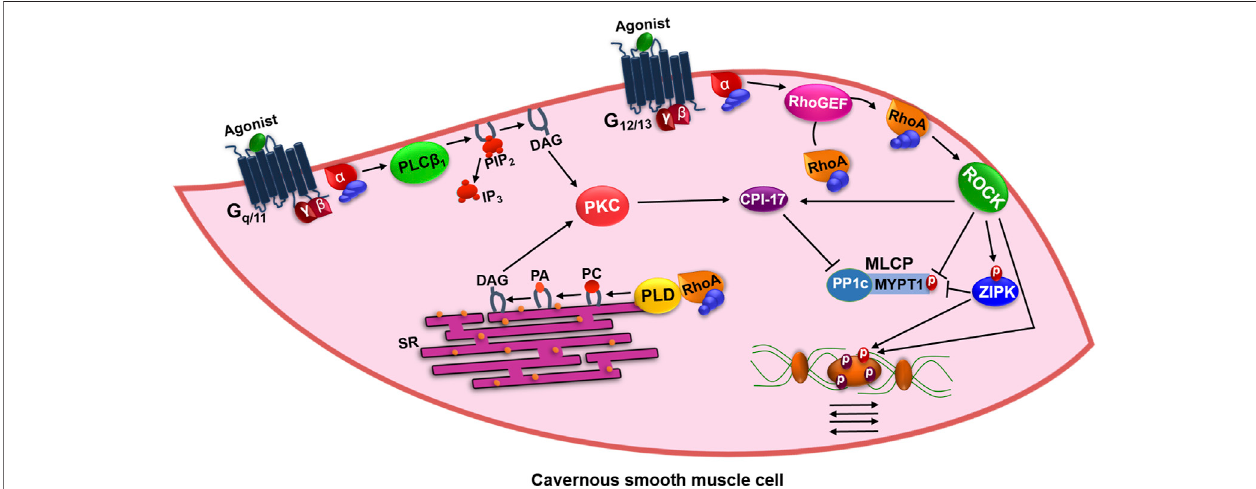
FIGURE 3 | Mechanism of maintenance of contraction in the cavernous smooth muscle by activation of G 12/13 /ROCK pathway. PLC β 1 : phospholipase C β 1 ; PIP 2 : phosphatidylinositol 4,5-bisphosphate; DAG: diacylglycerol; IP 3 :inositol 1,4,5-trisphosphate; SR:sarcoplasmic reticulum; PKC: Ca 2+ -dependent protein kinase; RhoA: small GTP binding protein G; PLD: phospholipase D; PC: phosphatidylcholine; PA: phosphatidic acid; RhoGEF: RhoA guanine nucleotide exchange factor; ROCK: kinase of RhoA; CPI-17: PKC-dependent phosphatase inhibitor of 17 kDa; ZIPK: zipper-interacting protein kinase; MLCP: myosin light chain phosphatase; MYPT1: regulatory subunit of MLCP; PP1c: catalytic subunit of